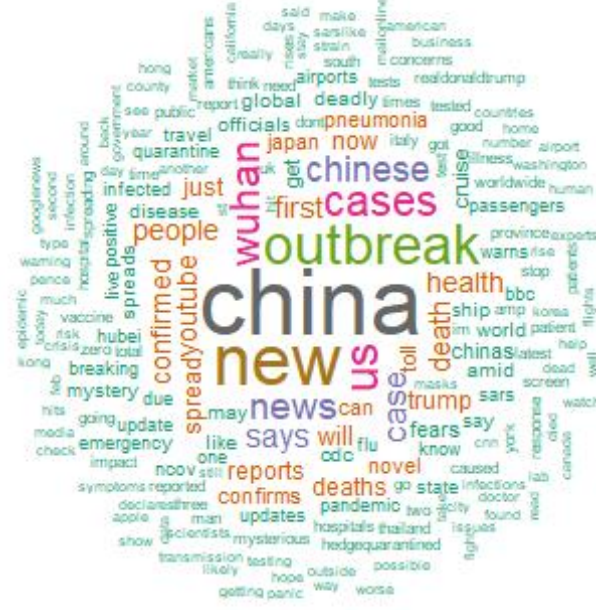
Figure 4. Word cloud showing the keywords appearing most frequently in tweets related to